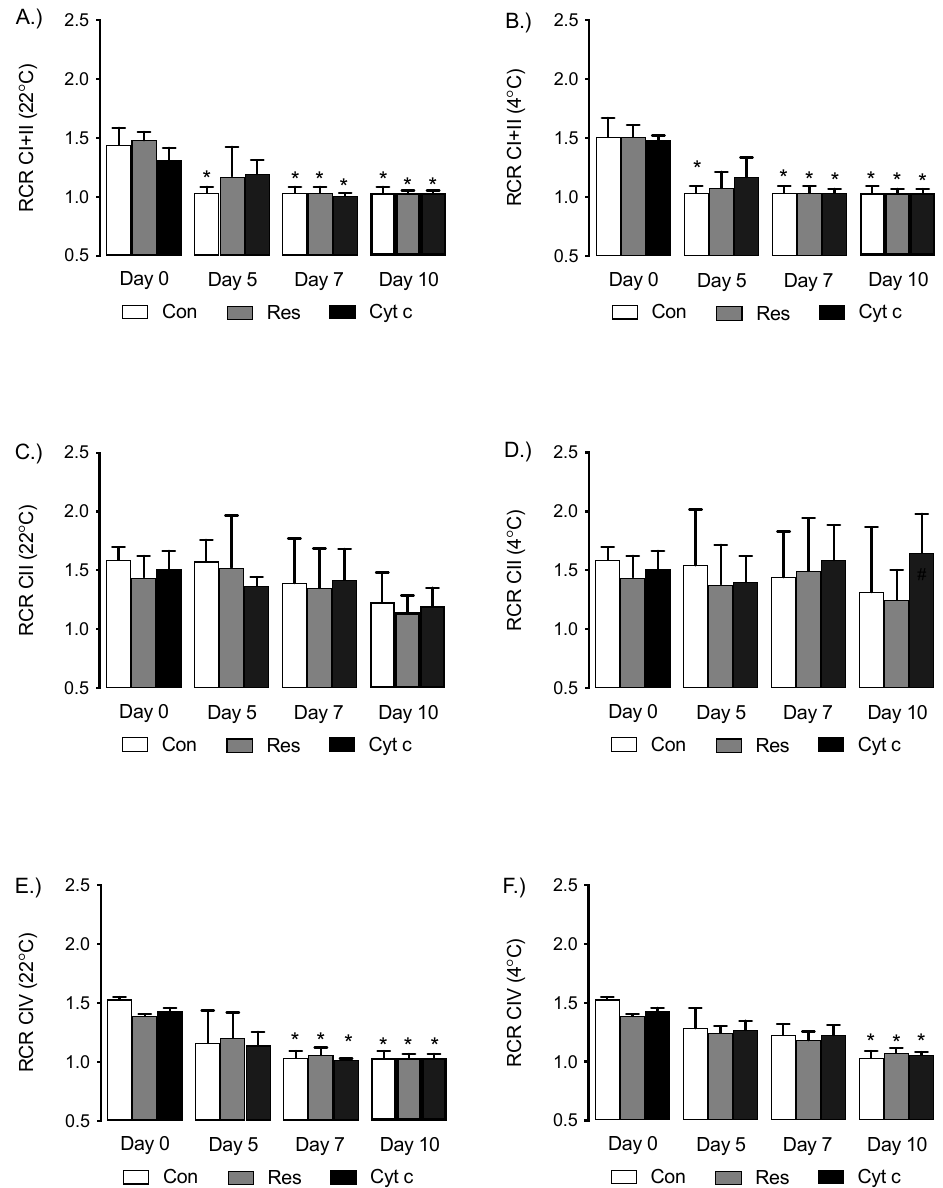
Figure 3. Respiratory control ratio (RCR; a measure of respiratory capacity) measured in platelets stored at 22 °C ( A , C , E ) and 4 °C ( B , D , F ). Platelets were exposed to glutamate (5 mm) + malate (2.5 mM) (CI+CII; A , B ), succinate (5 mM) + rotenone (2 uM) (CII; C , D ), or ascorbate (6 mM) + TMPD (300 uM) + antimycin (250 nM) (CIV; E , F ). * p < 0.05 versus treatment-matched day 0, n = 4 independent experiments.